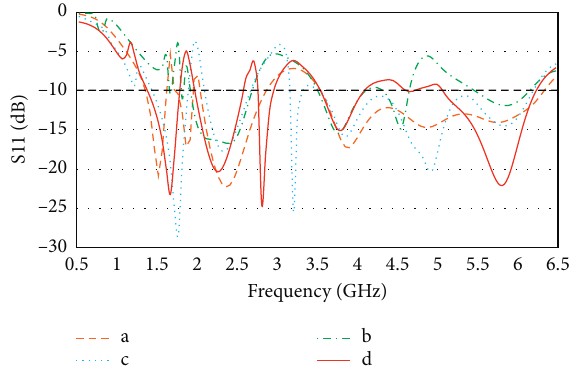
Figure 7: Variation of S11 (dB) for various H lengths.